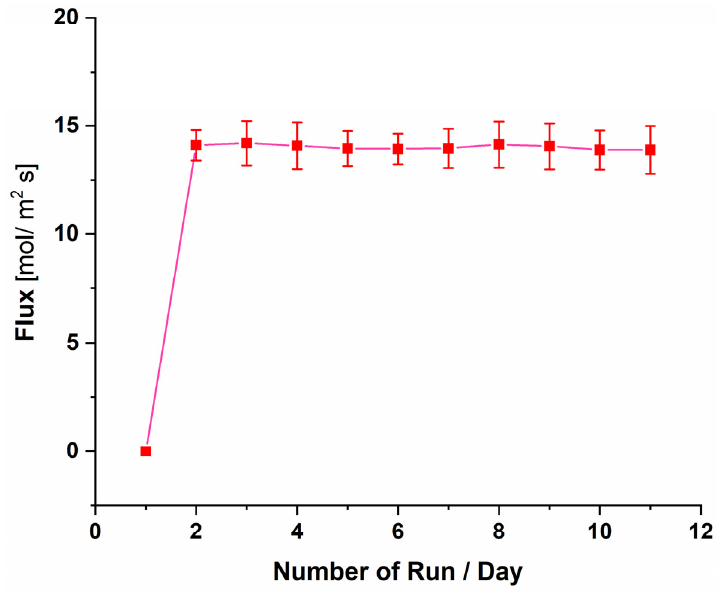
Figure 11. Stability of the membrane.